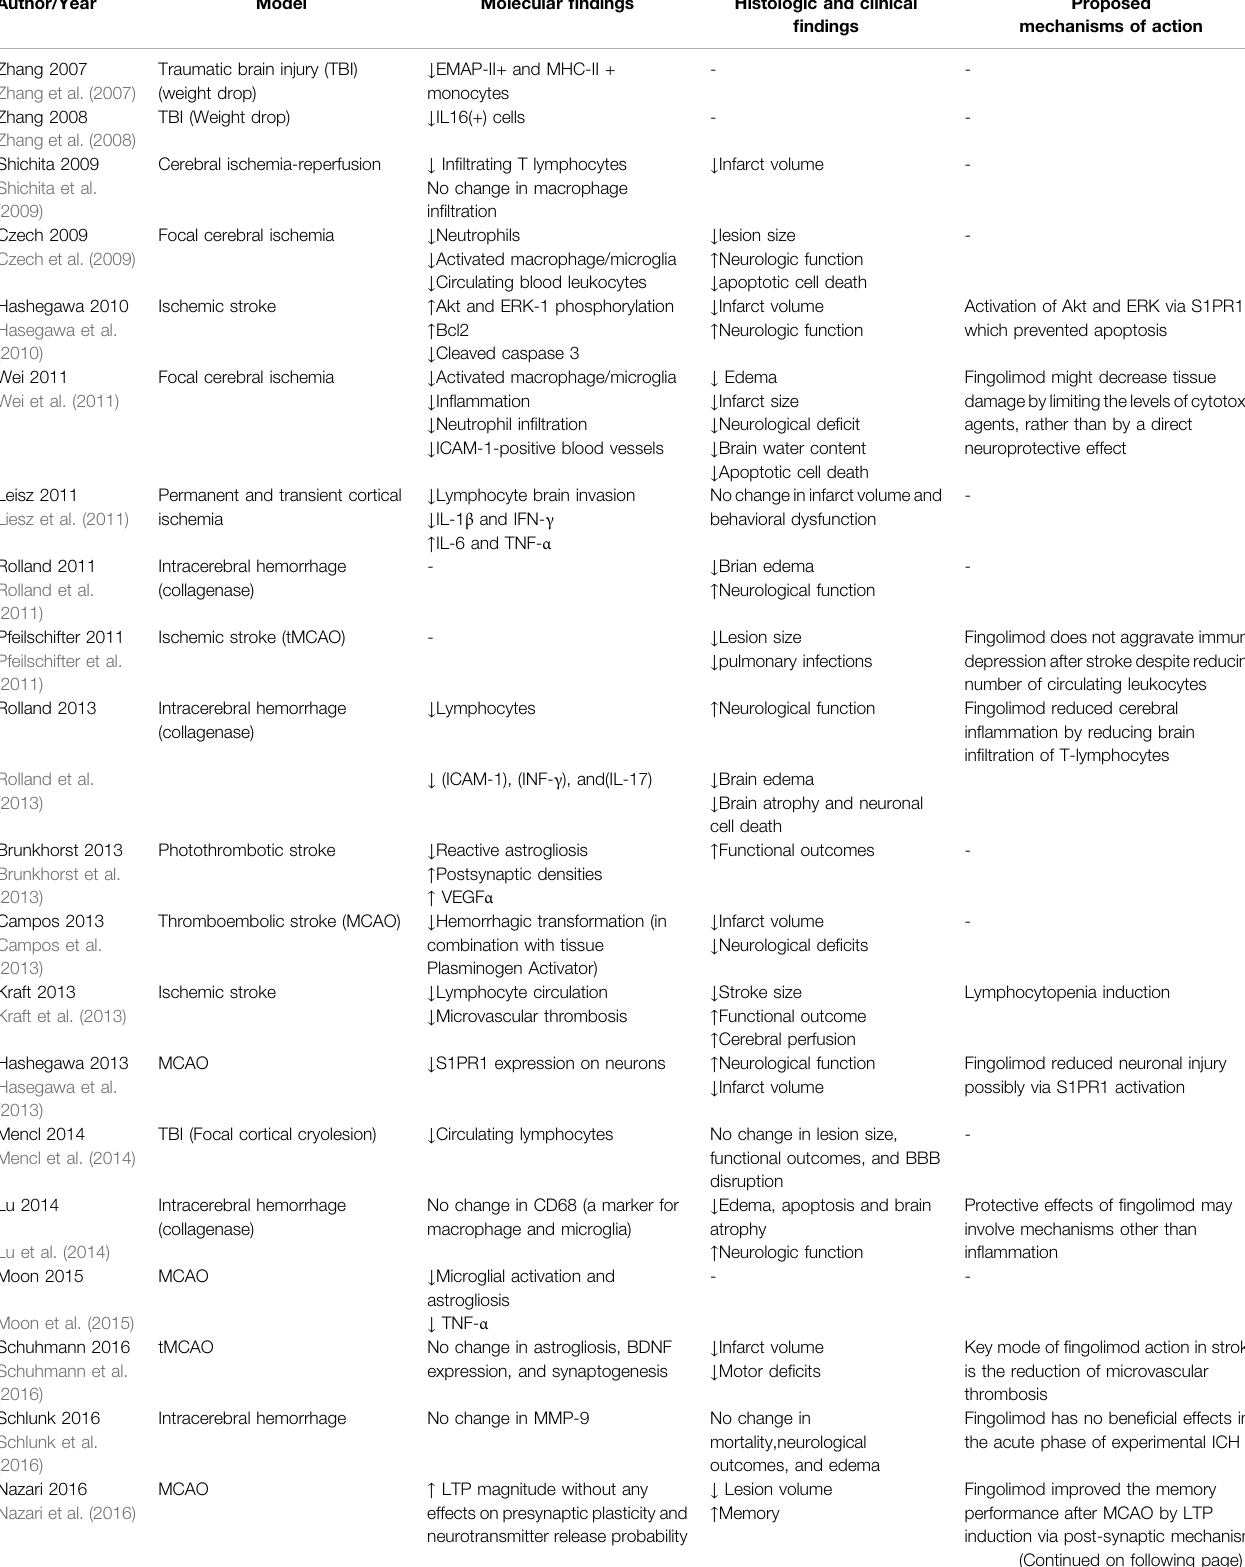
TABLE 3 | Summary of studies evaluating the effect of fi ngolimod in brain